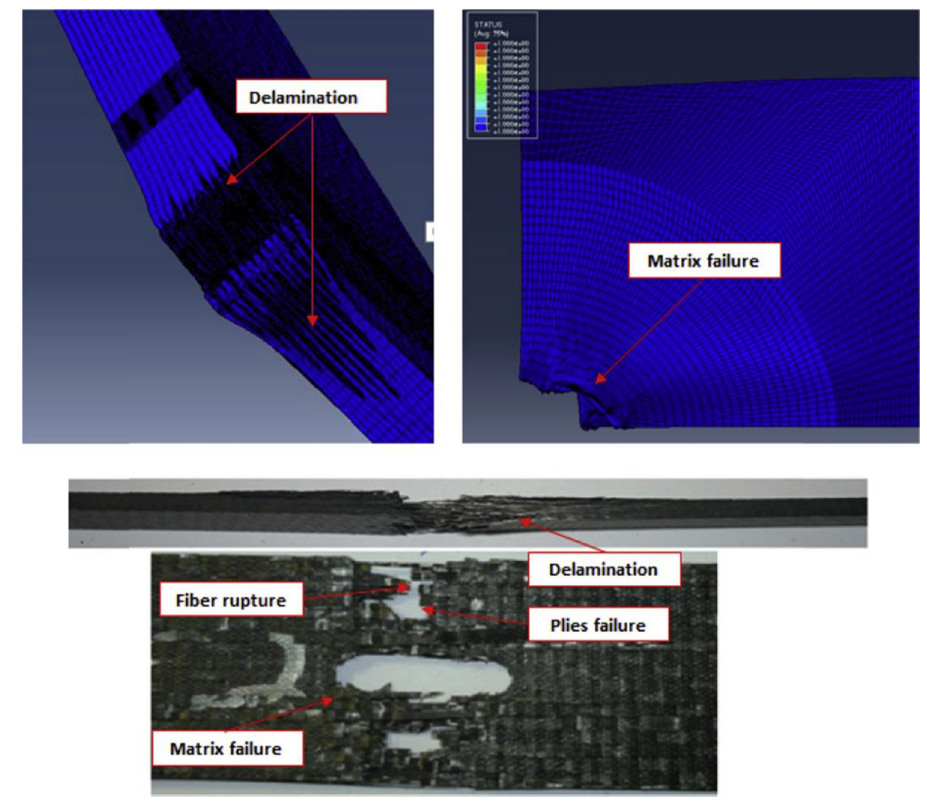
Figure 22: The delamination visualization comparison of OHT - cohesive model and experimental specimens [ 134 ]